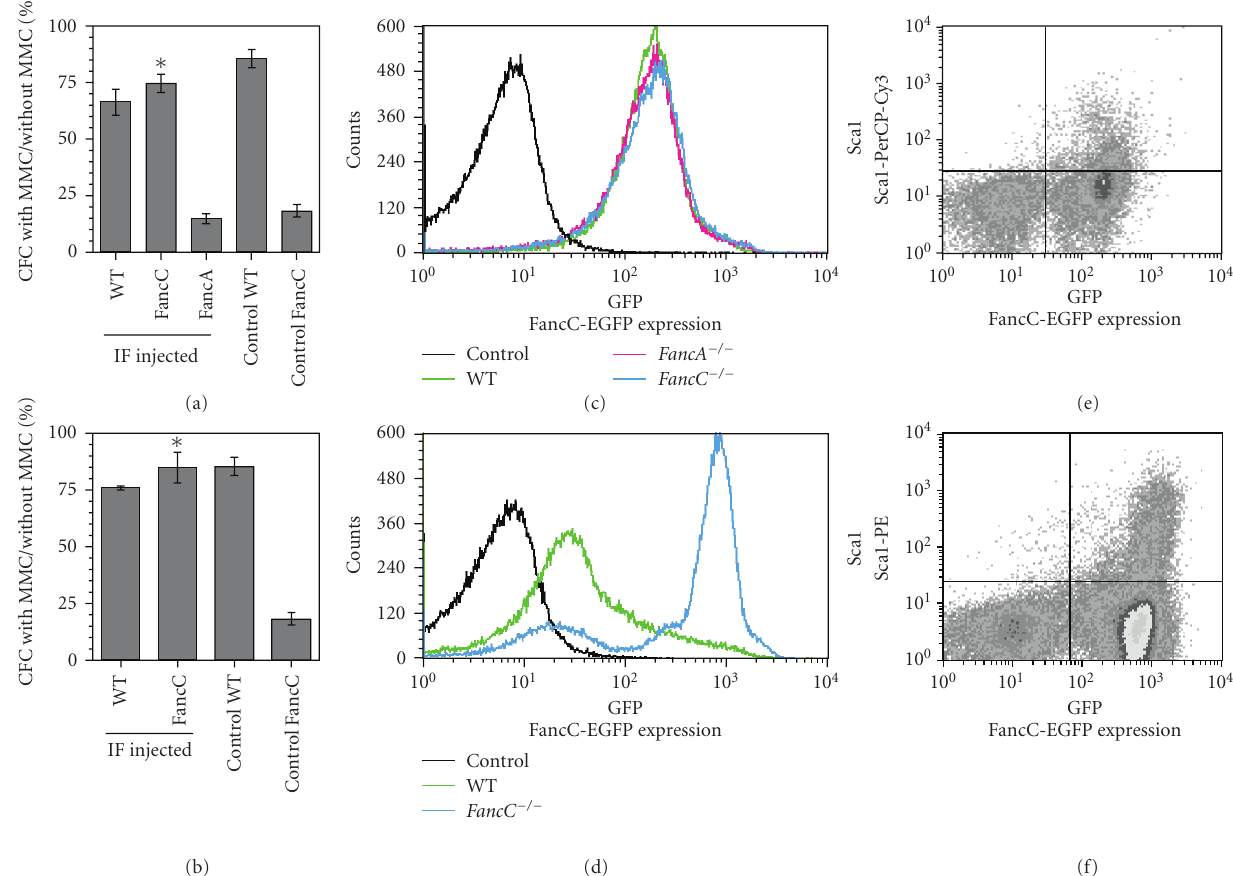
Figure 4: Functional correction of BM progenitors following LV-mediated FancC-EPFP gene transfer. CFC analysis of BM cells from IF-injected mice at four months following injection (a) and following chronic MMC treatments (b). Percent CFC numbers with MMC compared to cultures without MMC. Controls represent noninjected WT or FancC − / − mice. Data represent the mean ± SEM obtained from at least 3 mice in each group each done in triplicates. ∗ P < . 00005. (c) and (d) Representative cytometric profiles of FancC-EGFP expression in BM cells from IF-injected mice at four months following injection (c) and following chronic MMC treatment (d). (e) and (f) Representative cytometric profiles of FancC-EGFP expression in Sca1-positive BM cells from IF-injected FancC − / − mice at four months following injection (e) and following chronic MMC treatment (f). Table 1: Number of mice that survived MMC-treatments after LV-mediated intrafemoral gene transfer. Wild